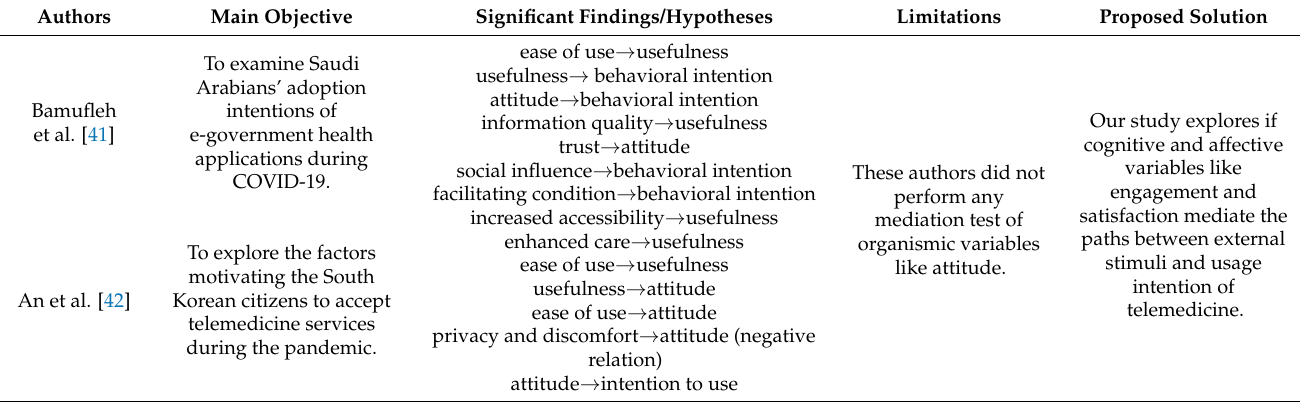
Table 1. Summary of the latest research on the context of telemedicine services in both developed and developing